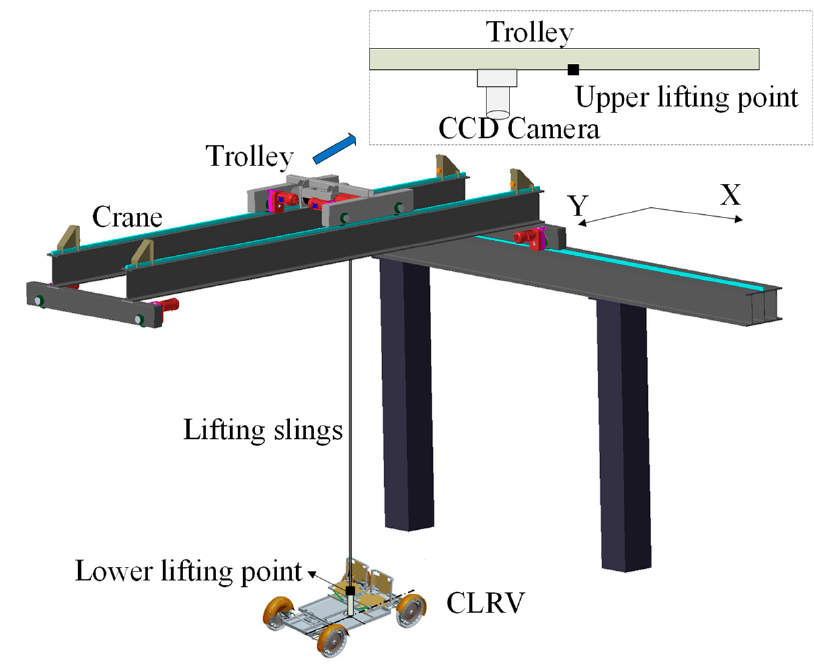
Figure 1. The structure diagram of LGCF.